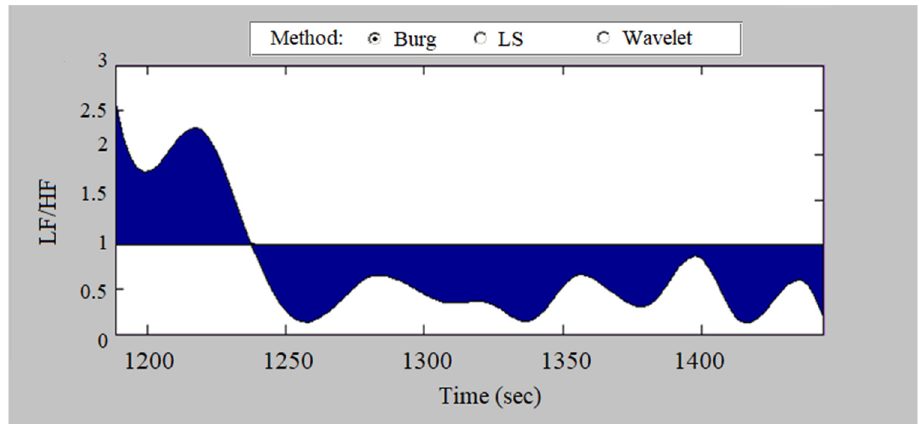
Figure 12. Dynamics of the values of the sympathovagal balance index (heart failure).